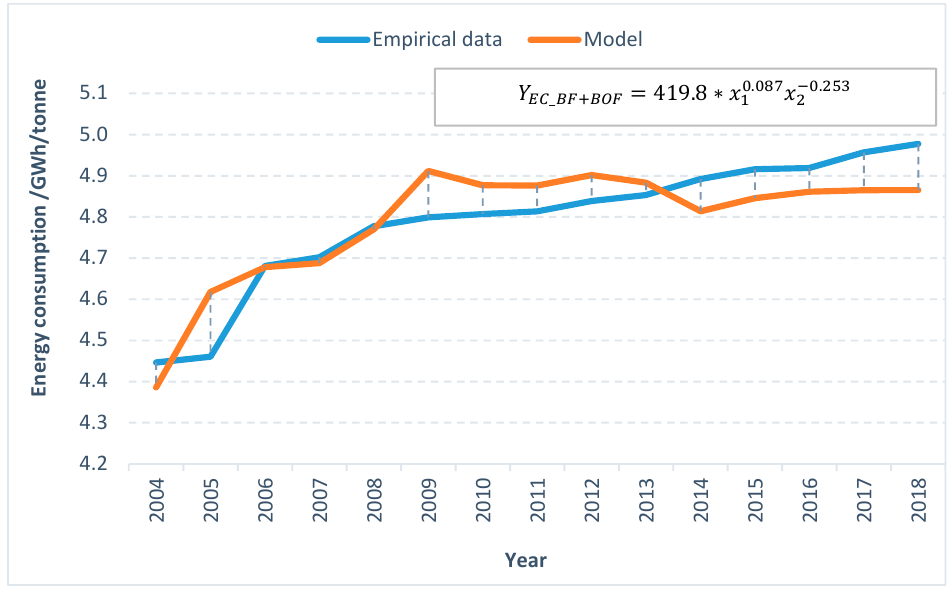
Figure 8. Presentation of the used model (2) and the empirical data in the analysed field.